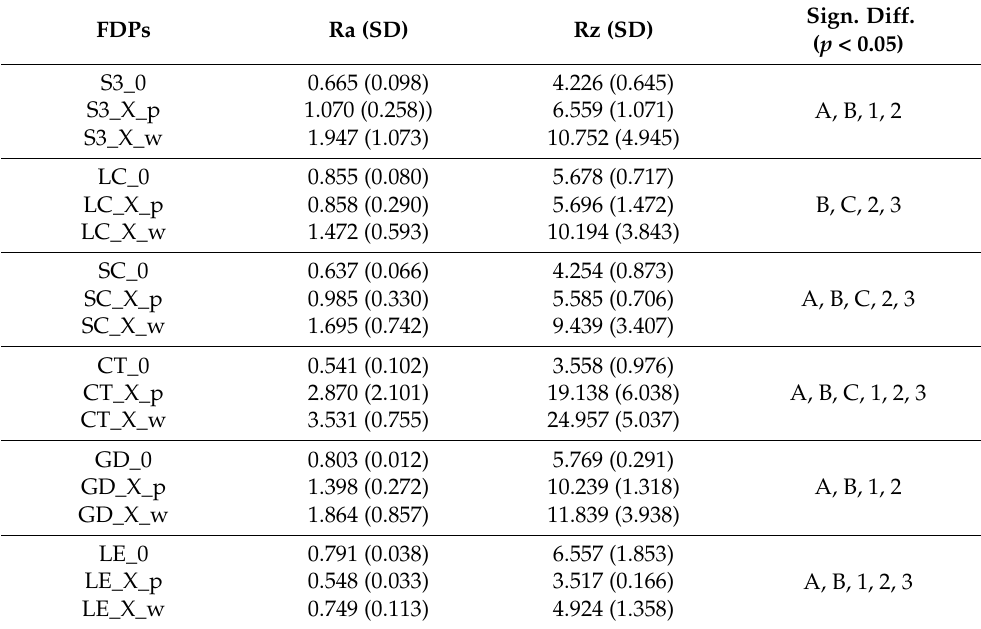
Table 6. Surface roughness values: Ra (in µ m) and Rz (in µ m) and standard deviations (SD); significant differences of roughness values between the different surface areas (0: unstressed sur- face prior to chewing simulation; X: stressed surface after chewing simulation; p: pressure point; w: downward